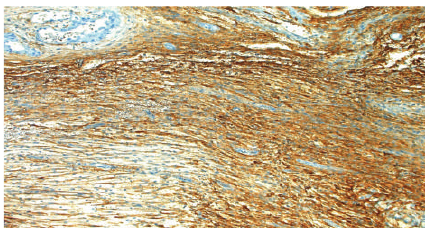
Figure 4: Areas of endometriosis in the ovarian stroma were positively stained with CD10 immune